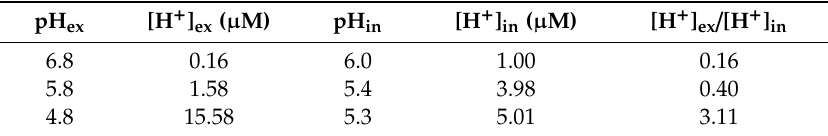
Figure 6. Determination of true transmembrane proton gradients and e ff ect of lactate uptake on yeast growth. ( a ) Calibration of the fluorescence intensity ratio to pH. ( b ) Determination of the yeast cytosolic pH adaptation in response to the external bu ff er pH. ( c ) Dependence of the lactate / lactic acid uptake capacity on the true transmembrane proton gradient (pH range 6.8 to 4.8). ( d ) Lactate dependent yeast growth (1:10 serial dilutions on agar plates) facilitated by PfFNT, MCT1, and AQP9. Table 1. Yeast transmembrane proton gradients at various external pH